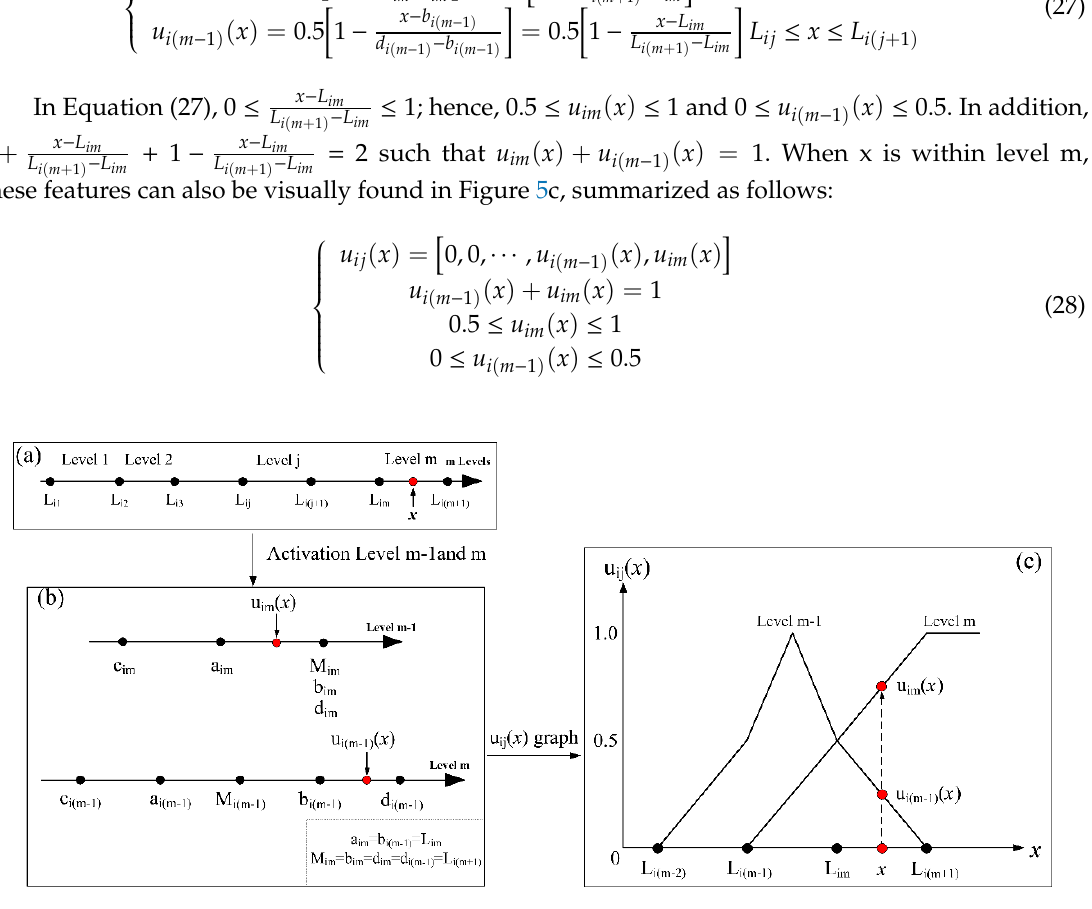
Figure 5. ( a ) The linear relationship between measured value 𝑥 and standard value 𝐿 𝑖𝑗 ; ( b ) the linear relationship between 𝑥 and the VFS model parameters c, a, M, b, and d on activation levels m and m − 1; ( c ) the position of the RMD value corresponding to x on the RMD function of activation levels m and m − 1.